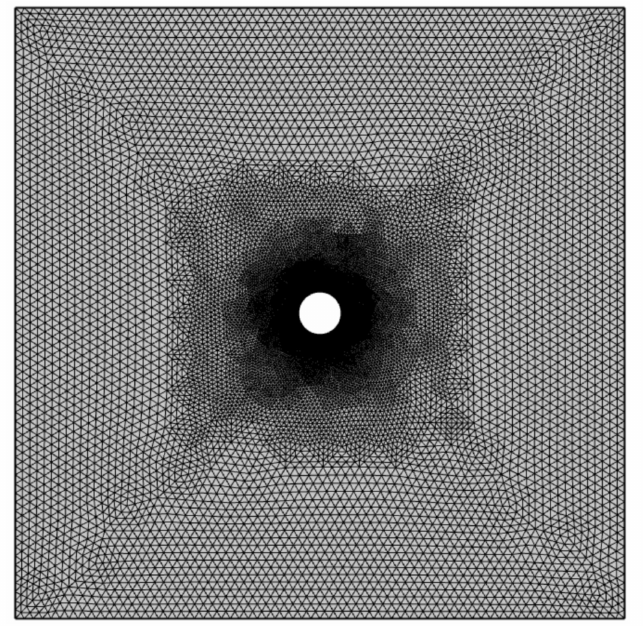
Figure 5. Mesh employed in the transient simulations performed to estimate α s .